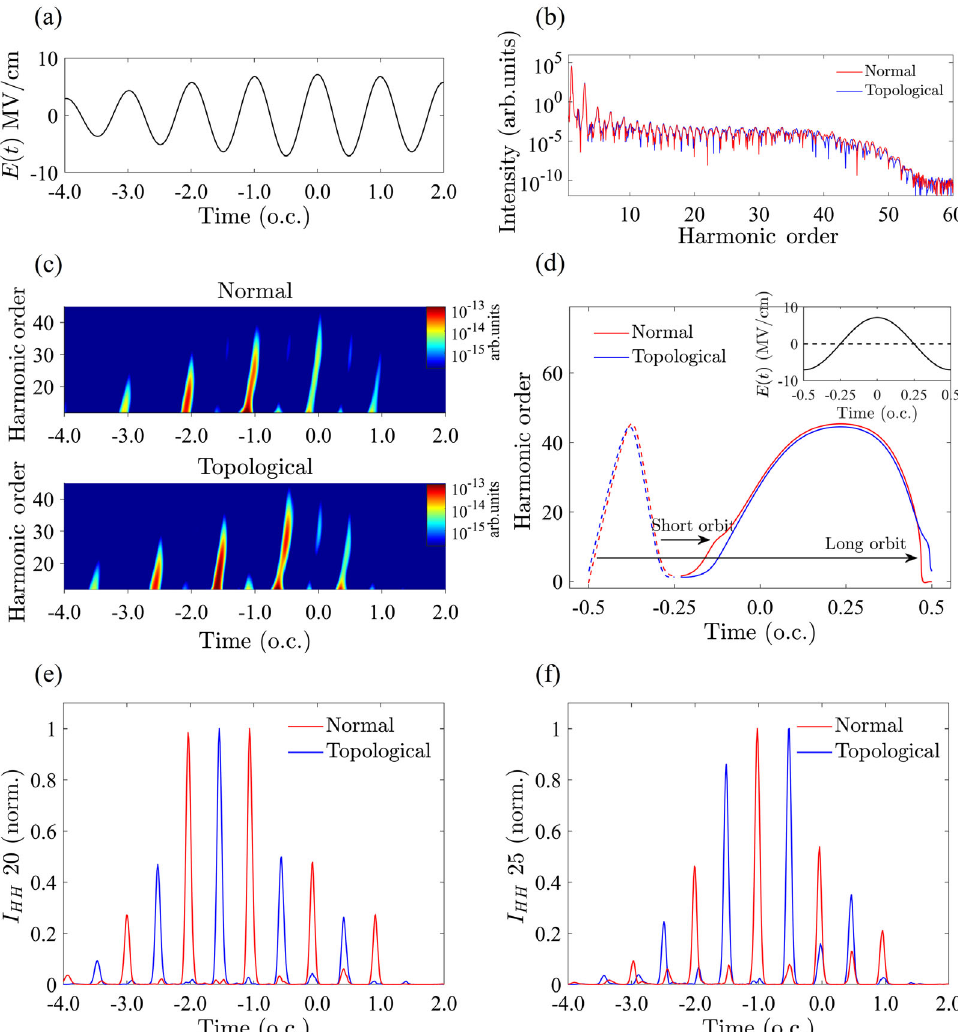
FIG. 4. HHG from normal and topological phases. (a) Waveform of the midinfrared driving fi eld with six main cycles. An optical cycle (o.c.) is 22.3 fs. (b) High-harmonic spectra of the NP and TP points. (c) Time-frequency spectrograms of the NP and TP points. (d) Saddle-point analysis as a function of birth time (dashed lines) and recollision time (solid lines) calculated by the saddle-point equations. The inset shows the laser-field strength in a single cycle. Normalized intensity of the (e) 20th and (f) 25th order HHPTs extracted from (c) to show their temporal fine